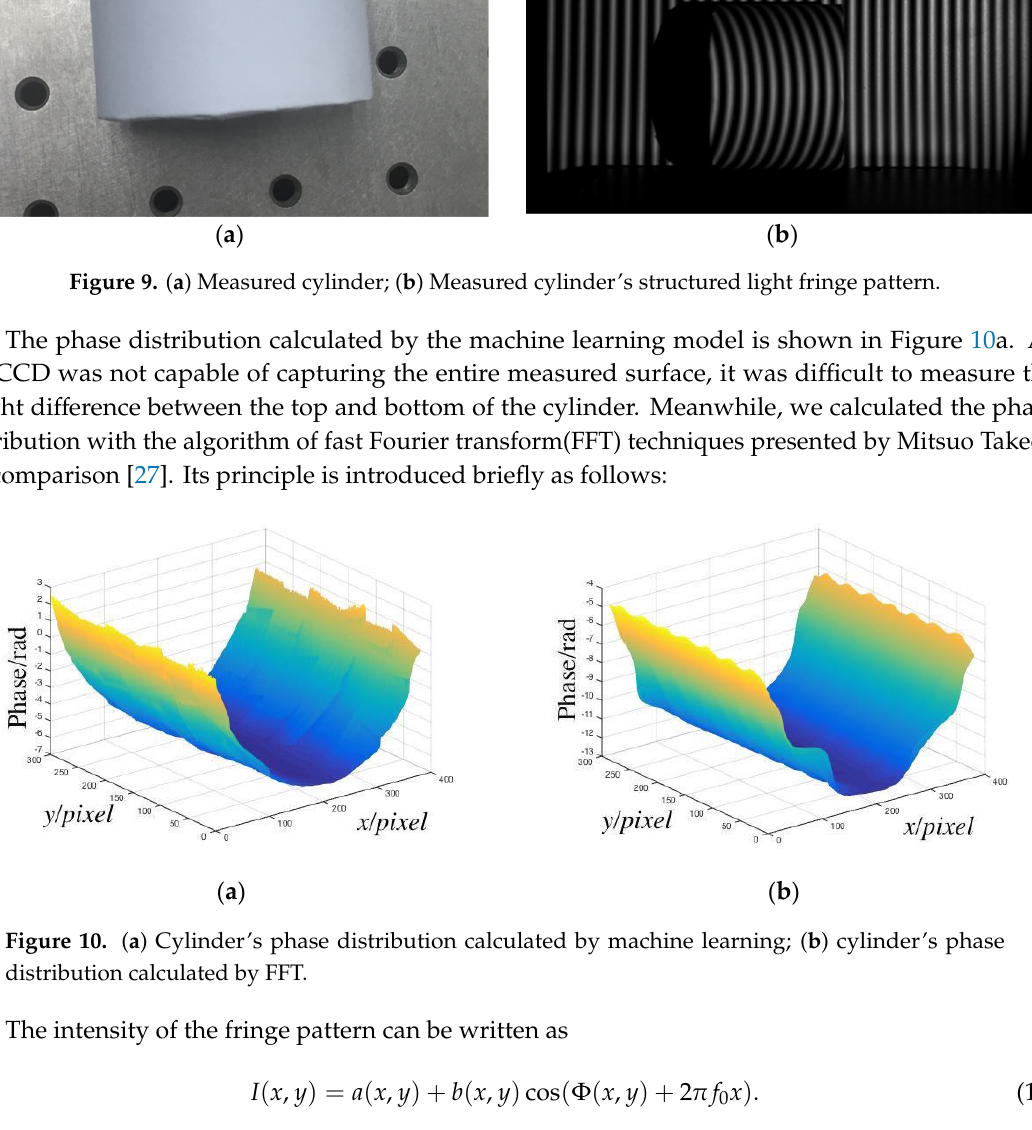
Sensors 2019 , 19 , x 9 of 13 Figure 8. Measurement errors corresponding to columns 480–529 . 3.3.2. Curved Surface To validate that our method could be used in a large range of applications, the phase distributions corresponding to two different curved surfaces were measured. Simple Curved Surface The cylinder is a typical simple curved surface, which is measured frequently in many industrial situations. Owing to its linear phase distribution on the x -axis, the model is the same as that of the